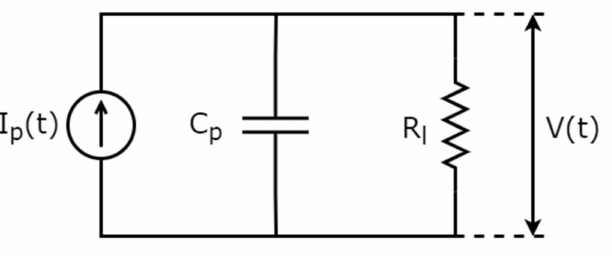
Figure 4. Modeling of piezoelectric patch in closed-circuit